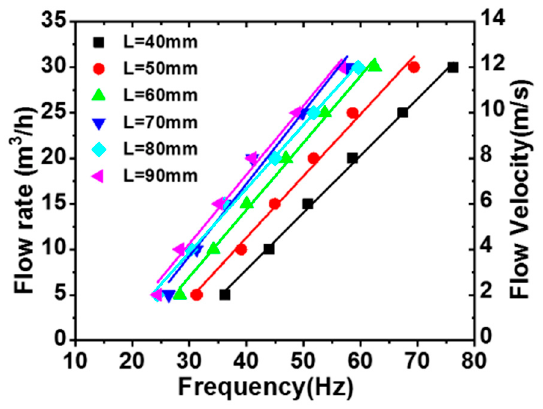
Figure 6. Pipe flow velocity and volume flow rate versus the flutter frequency.